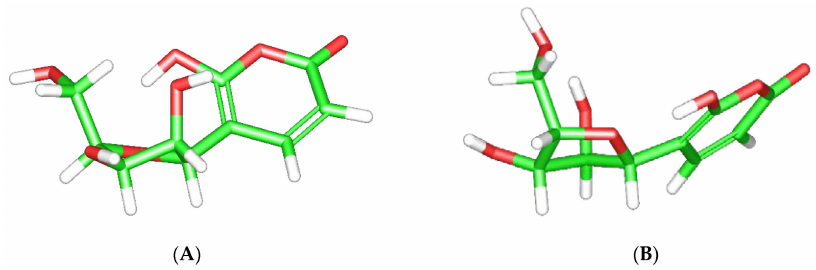
Figure 7. Representative conformers ( 2 E for β - D -C-lyxofuranoside ( A ) and 2 T 3 for β - L -C-lyxofuranoside ( B )) for the two enantiomers of Ochraceopyronide ( 1 ).